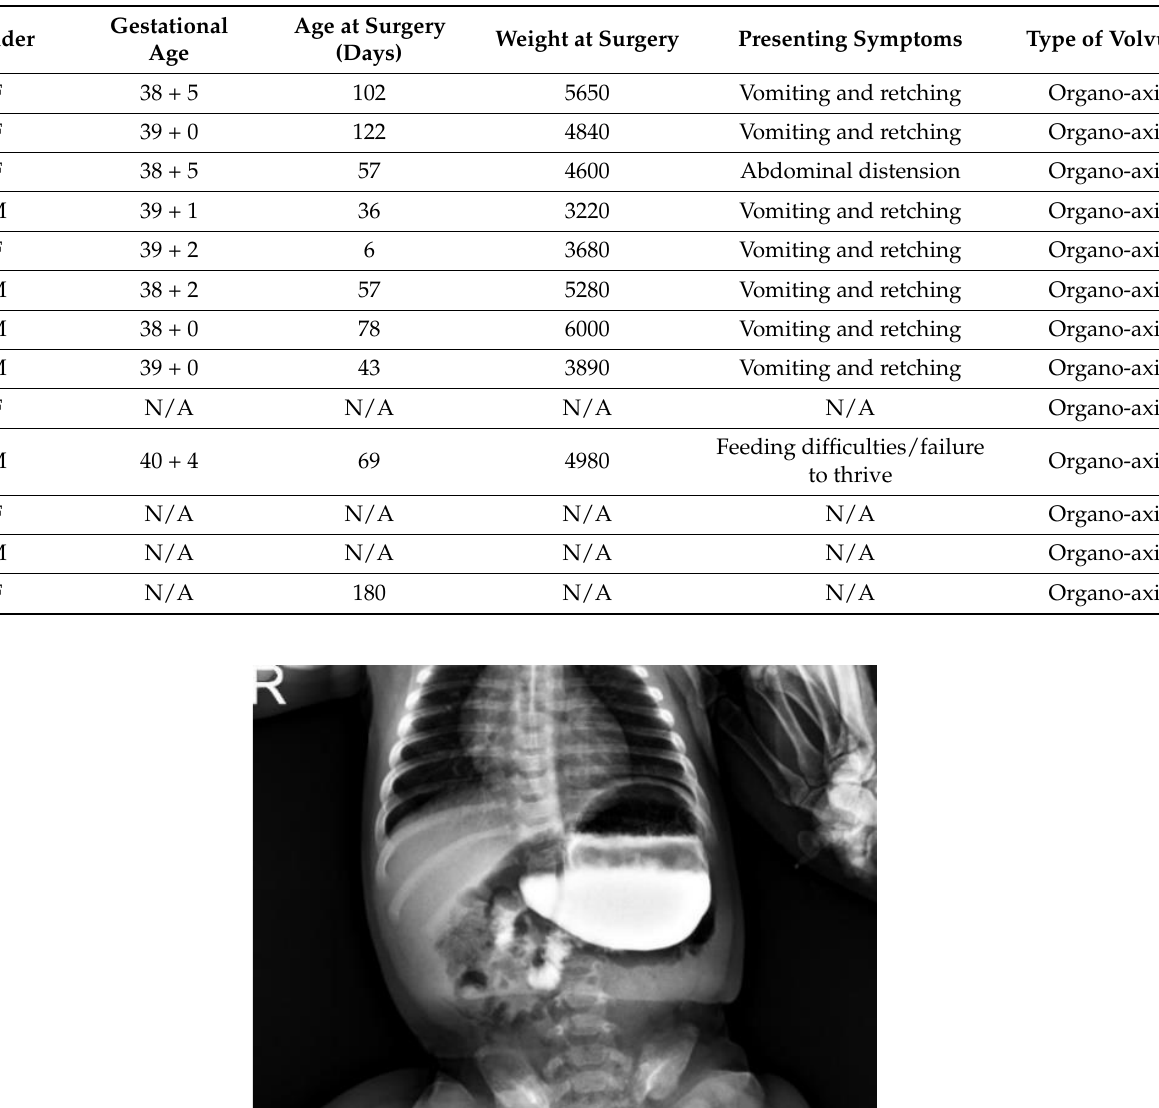
Table 1. Patient demographics and presenting symptoms.